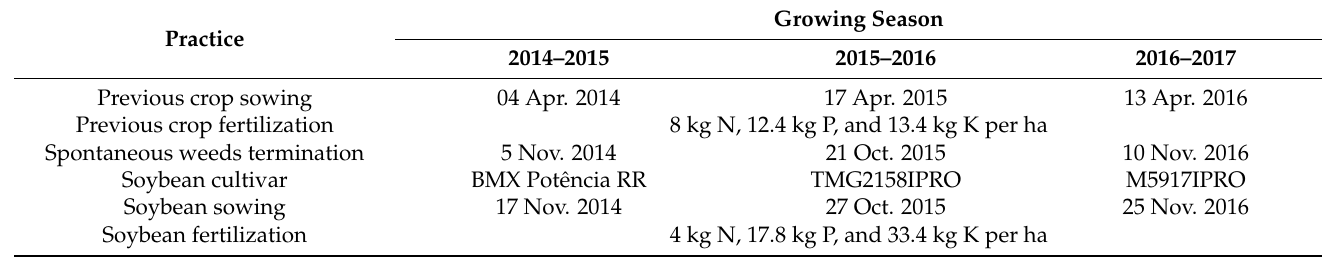
Table 1. Dates of agrotechnical practices, fertilizations, and soybean cultivars in each growing